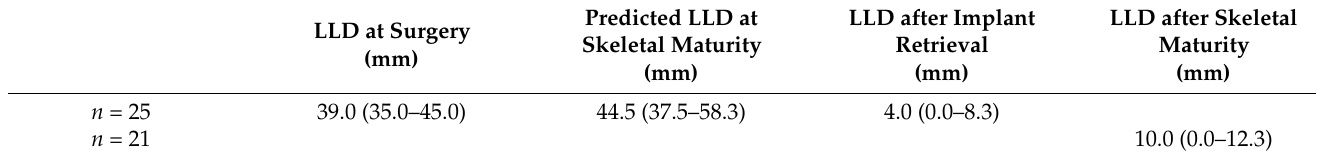
Table 4. Radiological parameters of limb